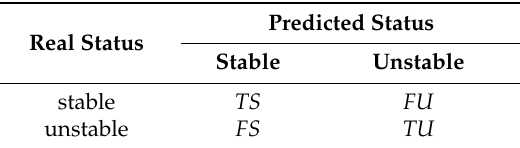
Table 1. Confusion Table 1. Confusion Matrix.